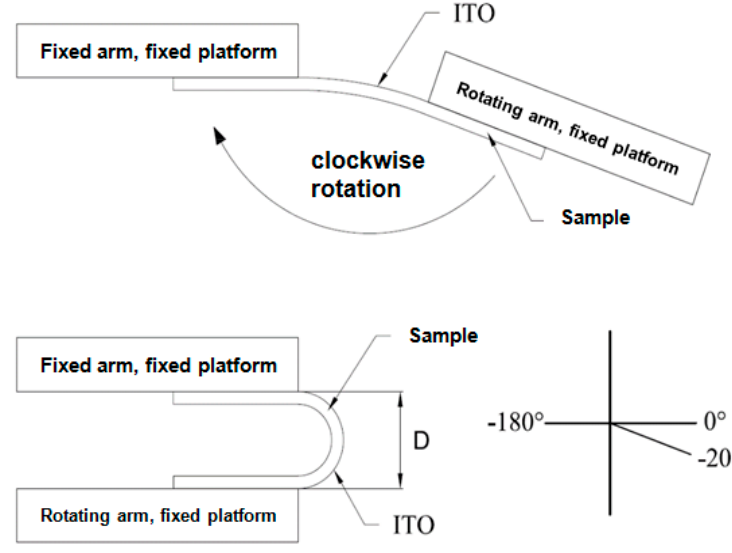
Figure 2. Schematic diagram of operating bending tester.